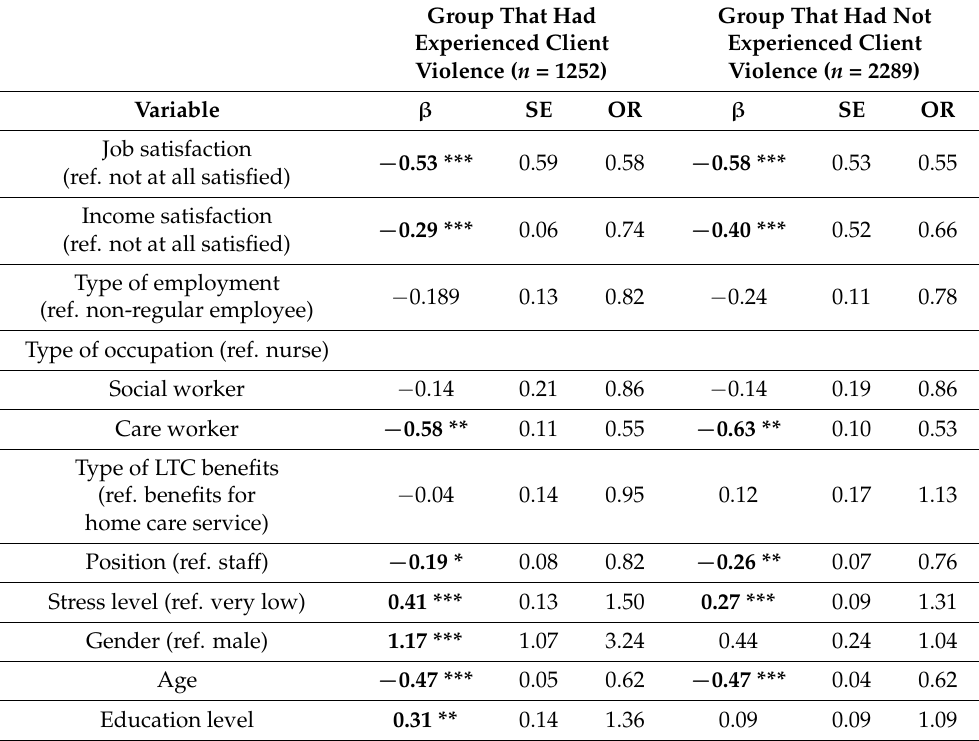
Table 6. Factors affecting turnover intention by experience of